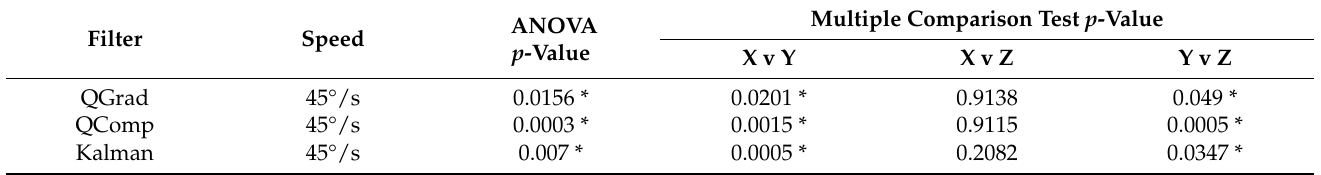
Table 5. Results of ANOVA and multiple comparison tests for the difference in mean error about X, Y, and Z axes at 45°/s for each filter without the magnetometer. Significant differences ( p < 0.05) indicated with an asterisk